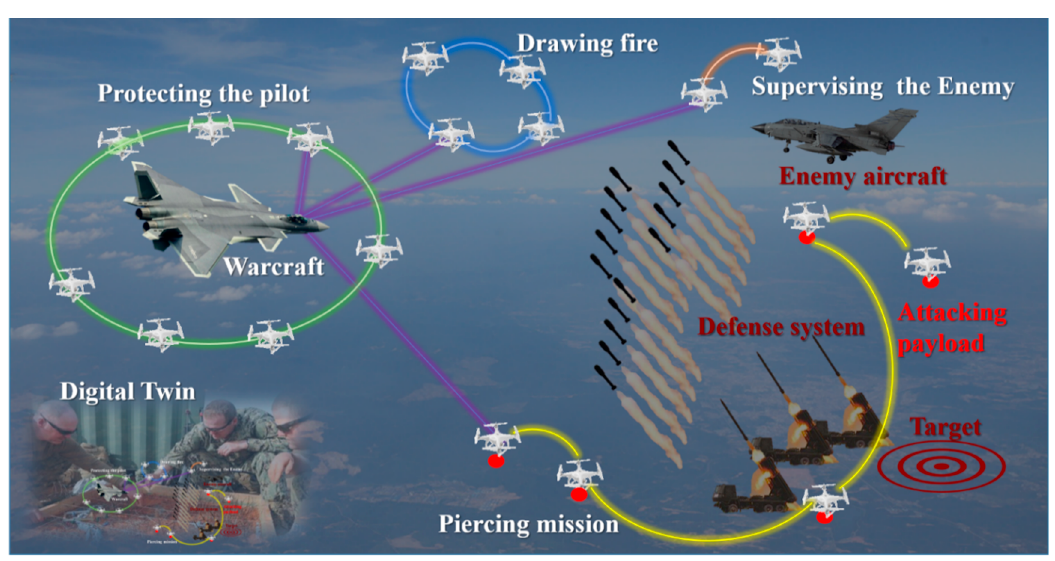
Figure 1. The application and necessary of understanding the environment. In a future war, the capacity of understanding unknown and complex environments would allow a UAV flock to complete more powerful missions.